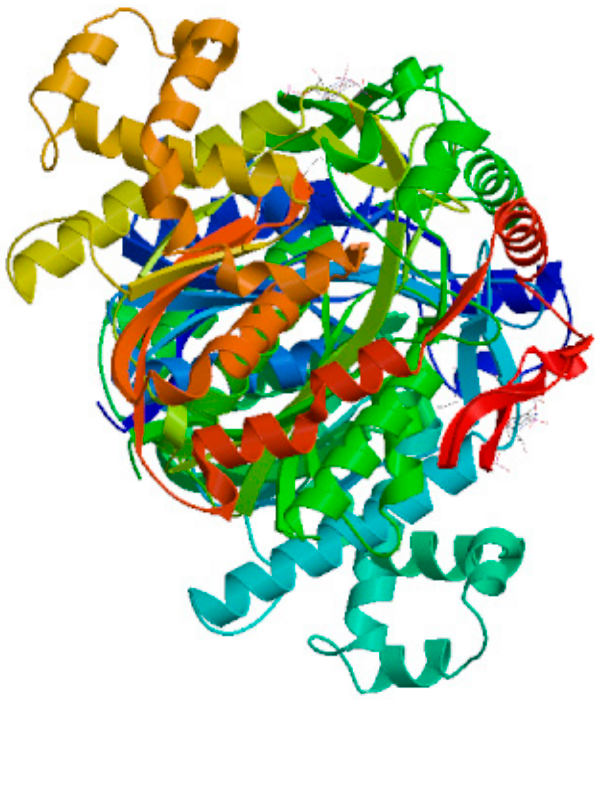
Figure 3. The 3D structure of Tw HMGS using homology-based